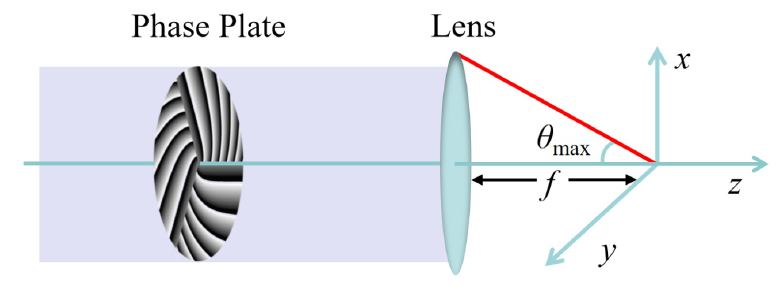
Figure 1. Schematic diagram of tight focusing of